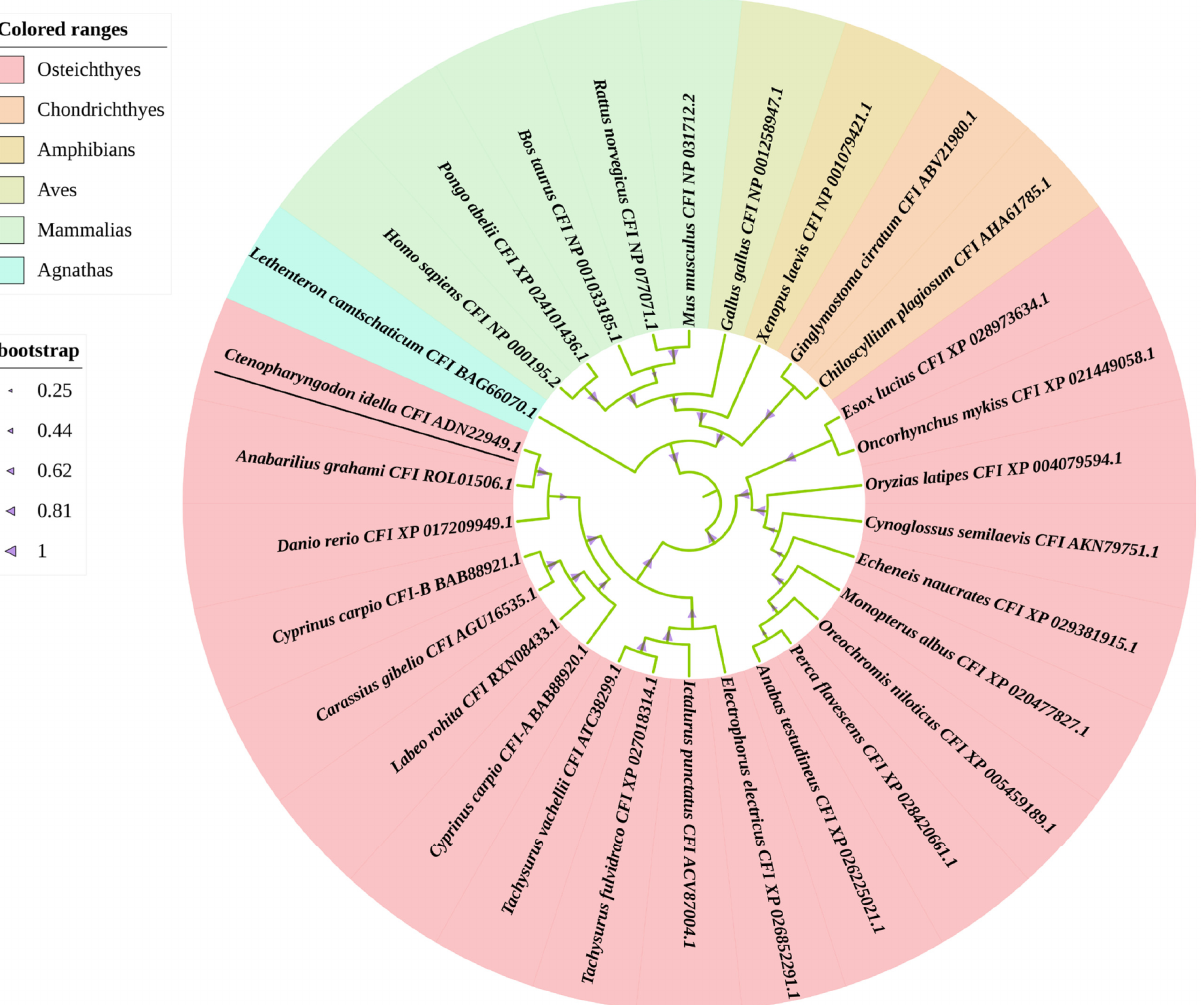
Figure 4. Phylogenetic tree constructed by NJ method for CFIs from various vertebrates. The CiCFI protein is underlined. All of the selected CFI proteins are separated into six branches that are marked by different colors.